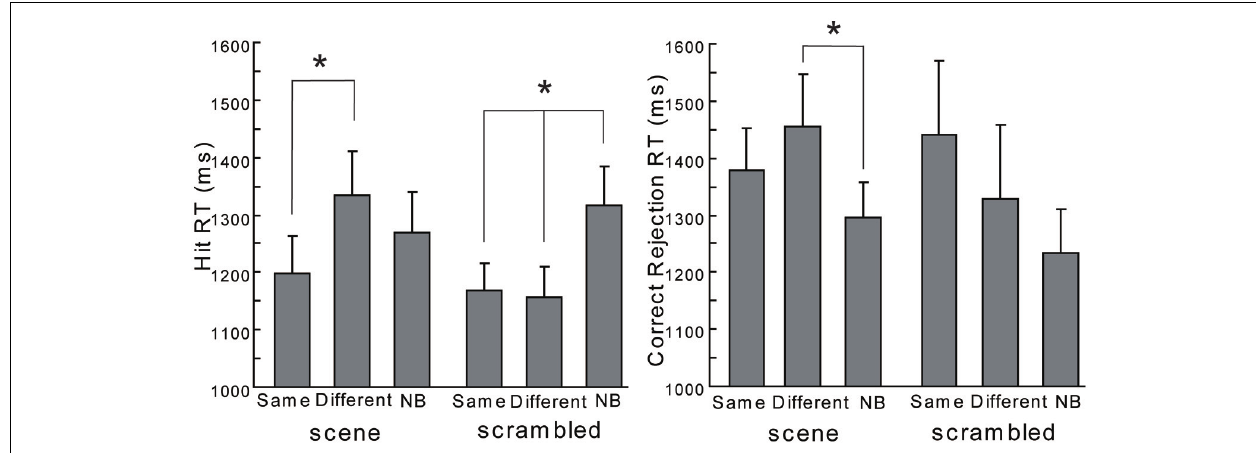
FIGURE 4 |The hit RT and the correct rejection RT in the current experiment. Error bars are standard errors of means.The asterisk means a significant difference ( p < 0.05).